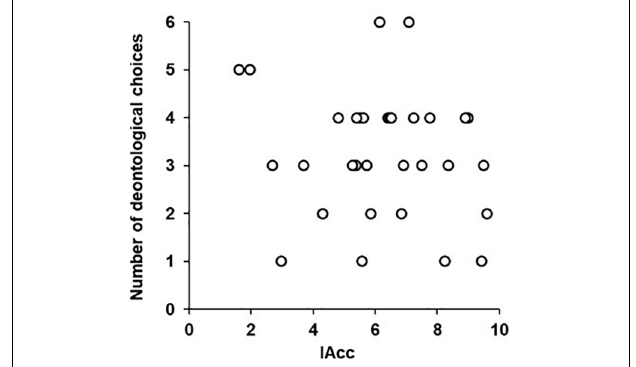
FIGURE 2 | Relation between IAcc and number of deontological choices.